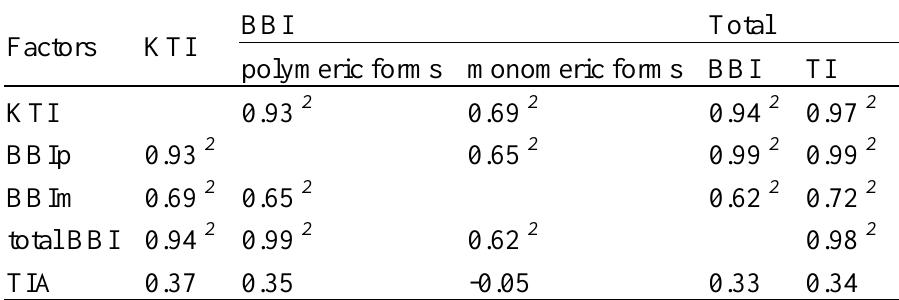
Table 2. Correlation Coefficients between Investigated Factors in Soybean Genotypes 1